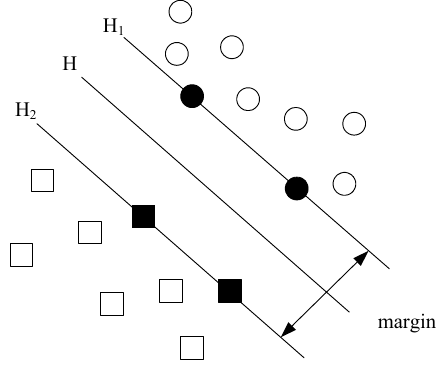
Figure 3. This figure shows the support vector machine (SVM) about two classes and linear separable separable problems. Margin means the geometric interval. problems. Margin means the geometric